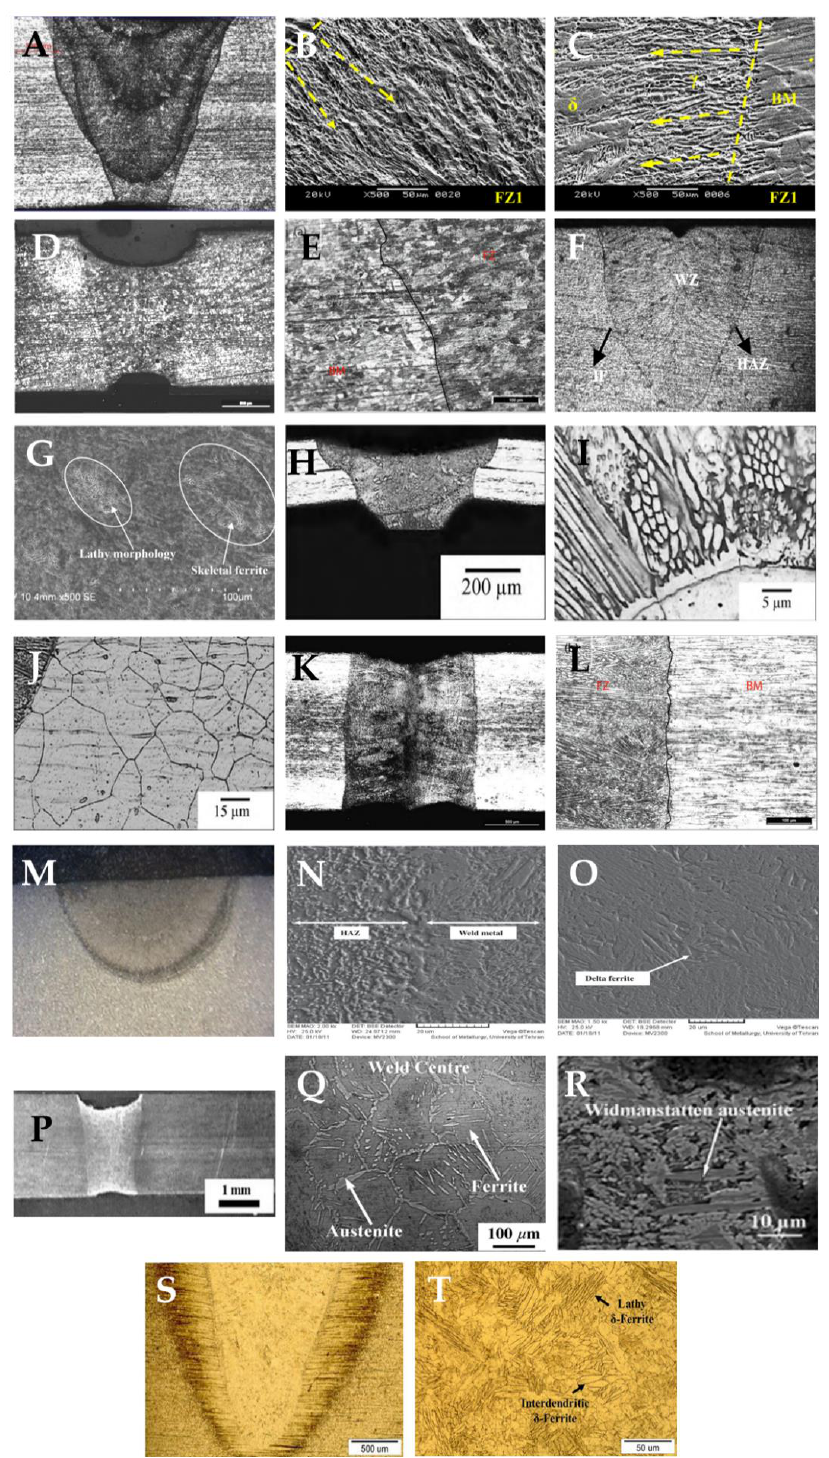
Figure 9. Pulsed laser weldments made of stainless steels: 304 ( A ), its HAZ ( B ) and FZ ( C ) [17]; 304L ( D ) and its weld interface ( E ) [7]; 301 stainless steel ( F ) and its FZ ( G ) [45]; 316L stainless steel ( H ), its HAZ ( I ) and FZ ( J ) [38]; 904L ( K ) and its weld interface ( L ) [7]; 420 stainless steel ( M ) joint and its HAZ ( N ) and FZ ( O ) [60]; UNS S32750 ( P ), its FZ ( Q ) [61] and FZ with PWHT(R) [62]; and 17-4 PH ( S ) and its HAZ ( T ) [64].